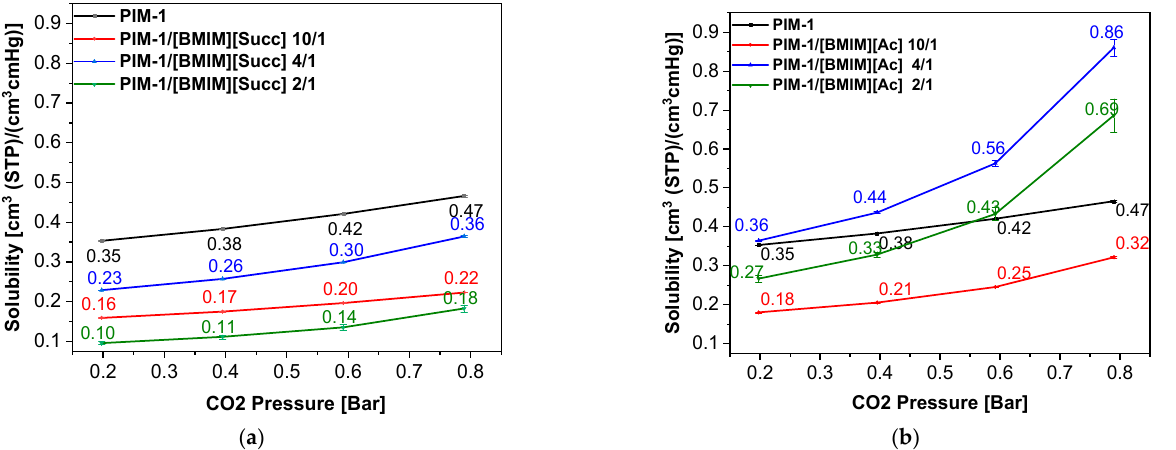
Figure 4. FESEM capture of surface ( a ) PIM-1, ( b ) PIM-1 /[BMIM][Ac] 10/1 and their cross sections ( c ) and ( d ), respectively.